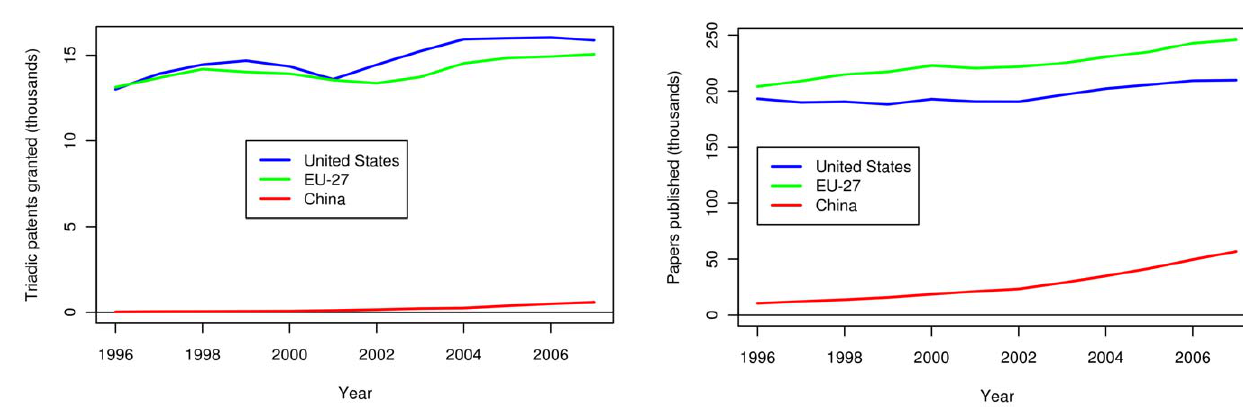
Figure 13. Recently published papers by researchers in the US, the EU-27 and China. Papers from journals included in the Science Citation Index and the Social Sciences Citation Index were enumerated. Each region received a fractional count based on the fraction of the institutions in the region.